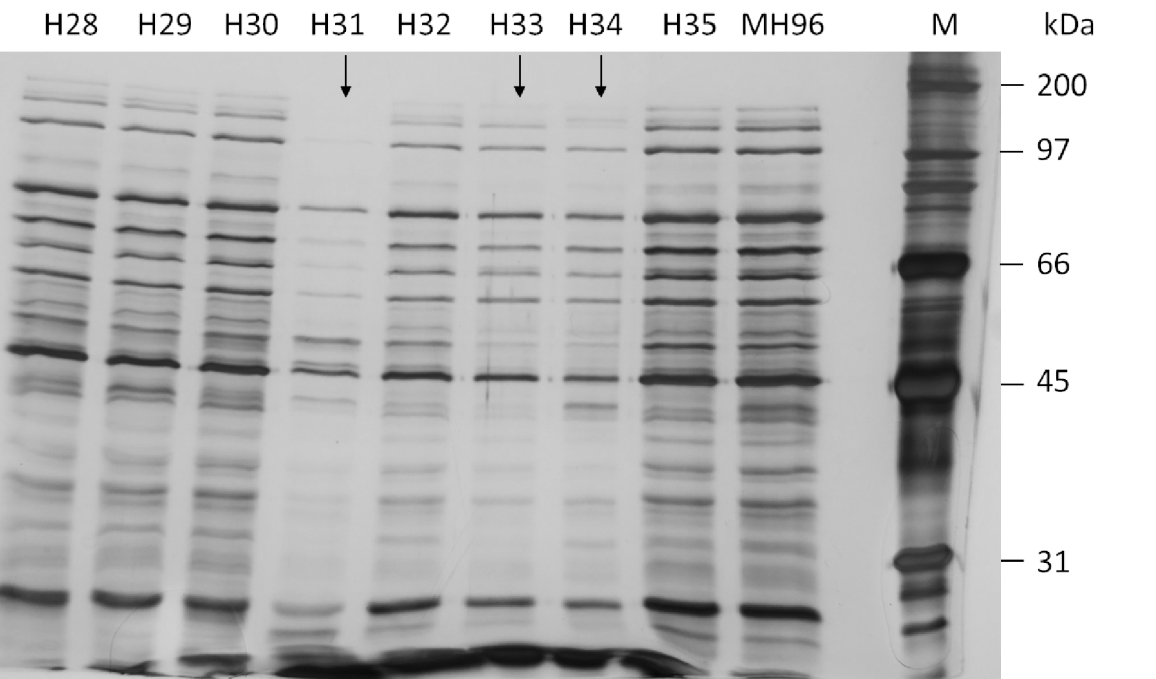
Fig 4. SDS-PAGE (10%) of culture supernatant of representative HESA-derived Tn5 mutants H28–35 (Table 1) cultured for 16 h. Transposon insertion sites, and CFUs compared to MH96 are listed in Table 1. Black arrows denote altered exoproteome profiles with decreased band intensities in transposon mutants relative to MH96. M, Bio-Rad broad-range marker.